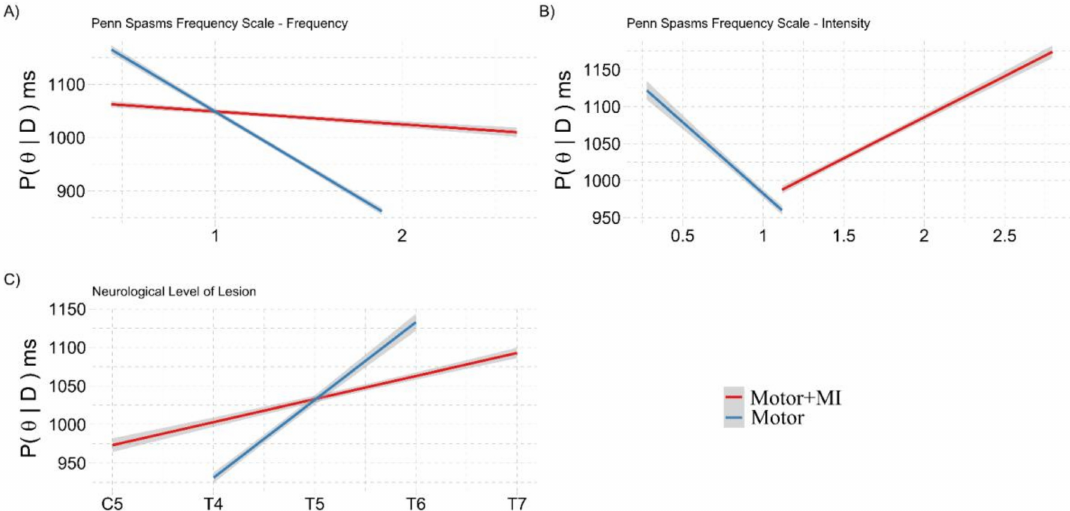
Figure 6. Graphical representation of the marginal posterior distributions of the interactions in the Covariation of the LLCCT paradigm in the REAL condition at T1 with NLI, PSFS and VMIQ-2 model. The y axis shows the marginal posterior distribution (P( θ |D)) in milliseconds, representing the performance of the participants. The x -axis refers to the covariates rescaled from z-scores to the original scores. All the graphical representations covariate the performance at the LLCCT task at T1 post-training (greater values on the y -axis represent a better PPS representation) with a different scale. The grey shading represents the 95% CI of the marginal posterior distributions. The x -axis of panels ( A , B ) shows the scores on the respective scales. The x -axis of the panel ( C ) shows the Neurological Level of